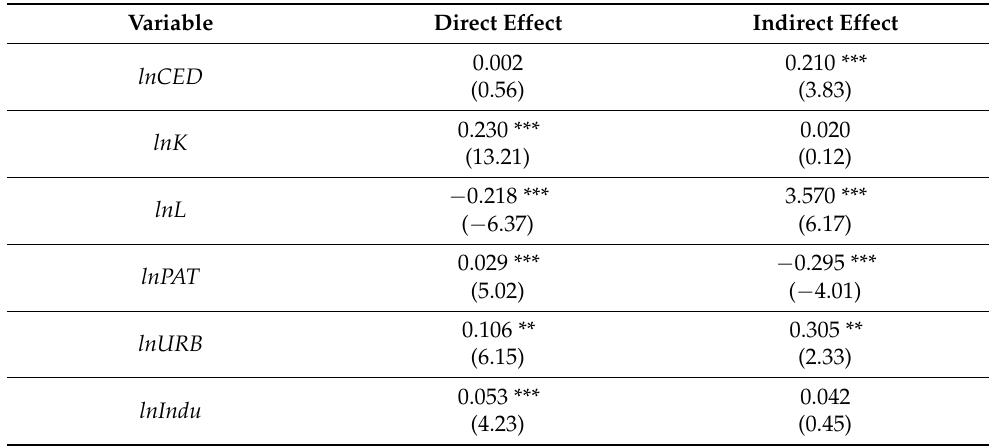
Table 6. The decomposition estimation results of the spatial effect of CED.